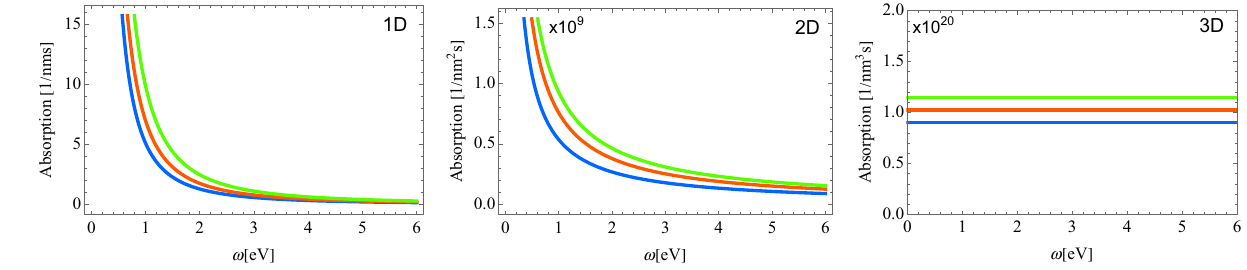
Figure 2. Absorption probabilities for 2b processes in different dimensionalities with various condensate densities. For 2D, the condensate densities are n 2 d (green). The other parameters are taken the same as in Fig.